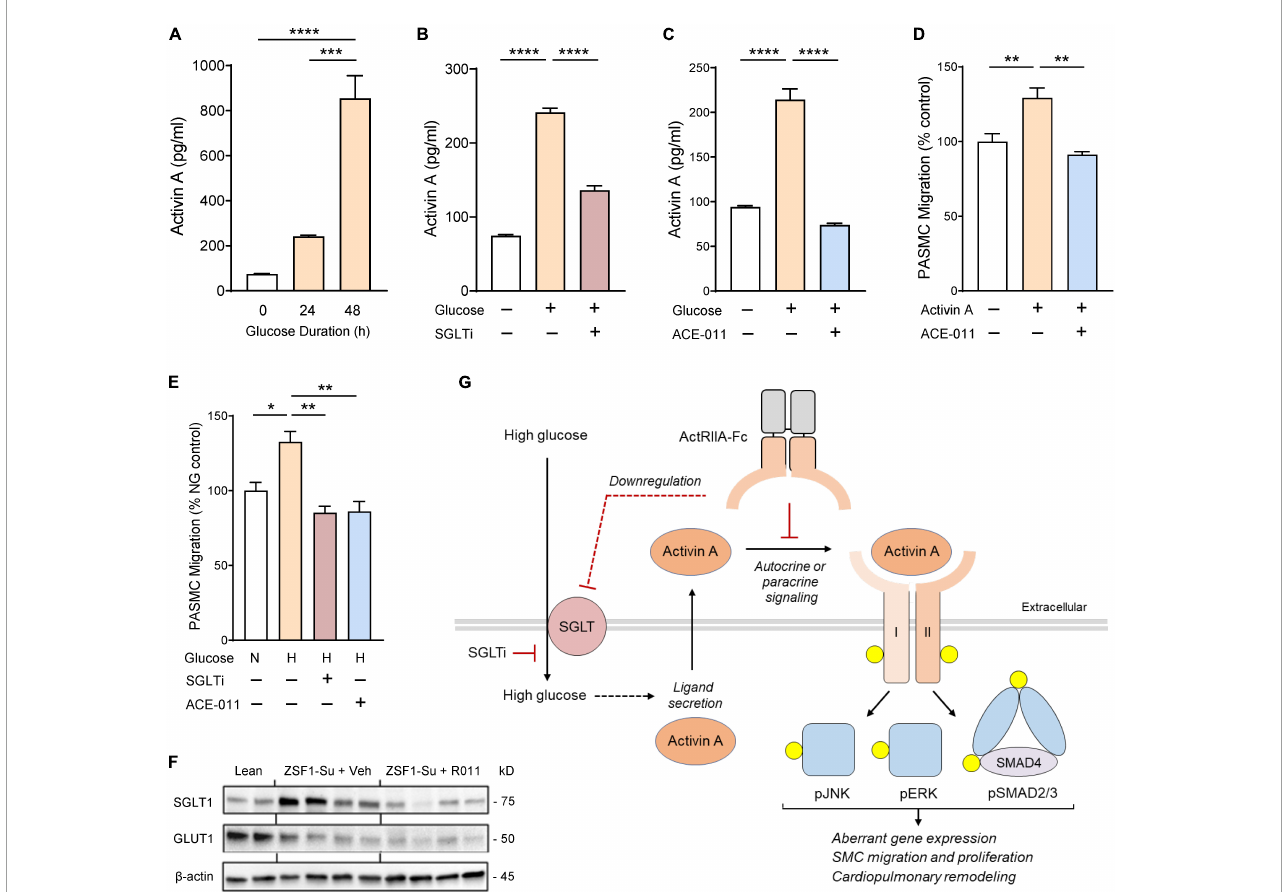
FIGURE7 ActRIIA-Fc inhibits glucose-induced release of activin A and migration by human pulmonary artery smooth muscle cells (PASMCs) mediated through the SGLT pathway. (A) Glucose-induced activin A release by hPASMCs. (B) Effect of SGLT inhibitor (SGLTi) sotagliflozin on glucose-induced release of activin A by hPASMCs. (C) Effect of human ActRIIA-Fc (ACE-011) on glucose-induced release of activin A by hPASMCs. (D) ACE-011 inhibits activin A-induced migration of hPASMCs. (E) Effects of SGLTi or ACE-011 on glucose-induced migration of hPASMCs. N or NG, normal glucose concentration (5 mM); H or HG, high glucose concentration (25 mM). Data are means ± SEM. Analysis by one-way ANOVA and Dunnett’s post-hoc test. * P < 0.05; ** P < 0.01; *** P < 0.001; **** P < 0.0001. (F) Effect of RAP-011 (R011) on dysregulated expression of glucose transporters in lung of obese ZSF1-Su rats. Lean, lean control rats; veh, vehicle (PBS). (G) Schematic overview of proposed mechanisms by which ActRIIA-Fc normalizes aberrant PASMC activity induced by high glucose levels in the obese ZSF1-Su rat. For clarity, activin A and its receptors are depicted as monomeric, and the non-covalent complex between mature activin A and its prodomain is not shown. Yellow circles identify phosphorylated proteins and dashed lines indicate mechanisms not yet delineated. I, activin receptor-like kinase 4 or 7; II, ActRIIA or ActRIIB; SGLT, sodium-glucose cotransporter; SGLTi, SGLT